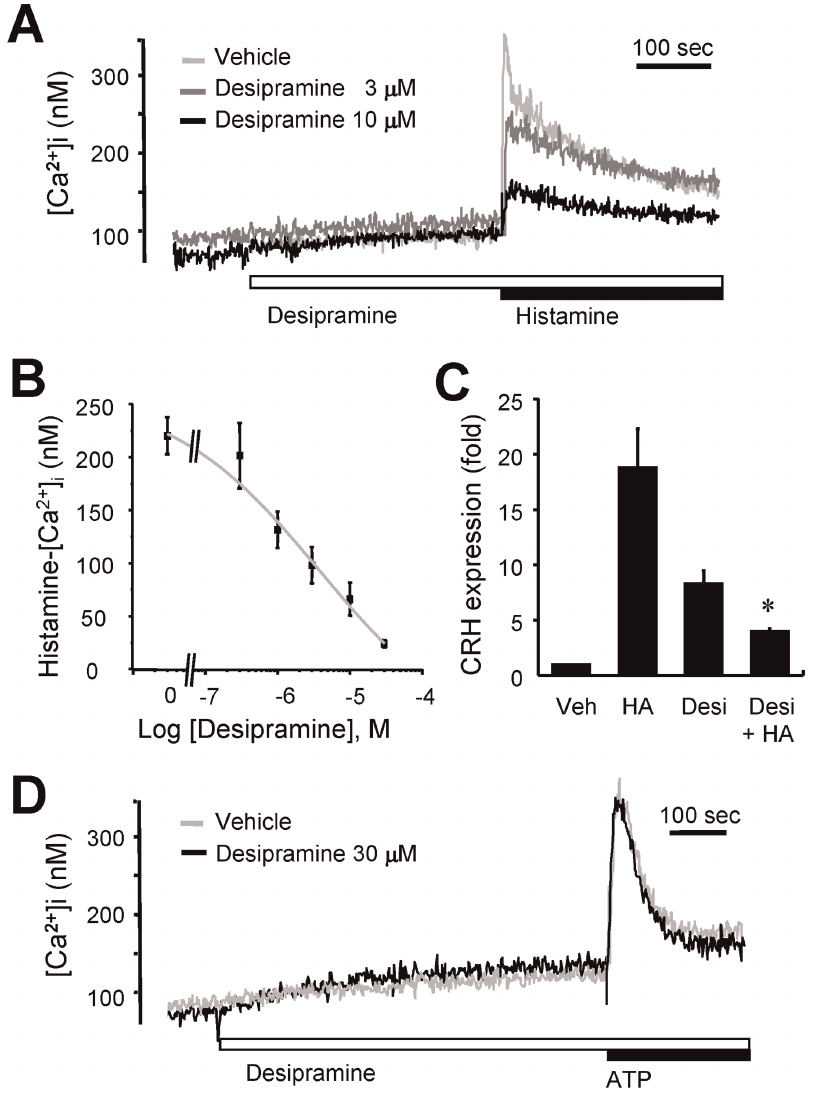
Figure 2. Desipramine inhibits the histamine-induced [Ca 2 + ]i rise and CRH expression in GT1-1 cells. (A) Fura-2-loaded GT1-1 cells were challenged with 100 m M histamine in the absence (light gray trace) or presence of 3 m M (gray trace) or 10 m M (black trace) desipramine. Cytosolic Ca 2 + concentrations were measured. Typical [Ca 2 + ]i traces from more than seven separate experiments are presented. (B) Cells were pretreated with various concentrations of desipramine before histamine (100 m M) treatment. The net increases in histamine-induced [Ca 2 + ]i are expressed with the mean 6 SEM. The experiment was performed independently three times. (C) GT1-1 cells were challenged with 100 m M histamine (HA) in the absence or presence of 10 m M desipramine (Desi), then total RNA was isolated from each sample, reverse transcribed and used to determine the amount of gene expression of CRH using real-time RT-PCR. The mean 6 SEM values of fold induction from three independent experiments are shown. *P , 0.05, compared to the response with histamine (HA). (D) Cells were challenged with 300 m M ATP in the presence (black trace) or absence (gray trace) of 30 m M desipramine. Typical [Ca 2 + ]i traces from more than three separate experiments are presented. All results were reproducible. doi:10.1371/journal.pone.0036185.g002 modulating neurotransmitter). In primary rat hypothalamic cells, receptor subtypes. Chlorpheniramine (1 m M, histamine H1 we also found that preincubation with chlorpheniramine (1 m M) receptor-specific antagonist) decreased the increase in [Ca 2 + ]i completely blocked histamine-induced [Ca 2 + ]i increase (Fig. 3E). induced by histamine, whereas ranitidine (1 m M, histamine H2- specific antagonist) and thioperamide (1 m M, histamine H3 and H4 receptor-specific antagonist) had little effect in GT1-1 cells (Fig. 3A, B, C). Histamine (100 m M) did not elevate cytosolic cAMP, which indicates the lack of functional H2 receptors that are linked to adenylyl cyclase (Fig. 3D). By contrast, there was Certain tricyclic antidepressants, including desipramine, are a marked elevation of cAMP in response to NDP-MSH (20 m M), known to block the reuptake of catecholamines in catecholamine- an agonist for the adenylyl cyclase-coupled MC4 receptor, which secreting neurons. It is thus possible that blockade of catechol- is known to be activated by a -melanocortin (one of appetite- amine reuptake by desipramine results in the accumulation of